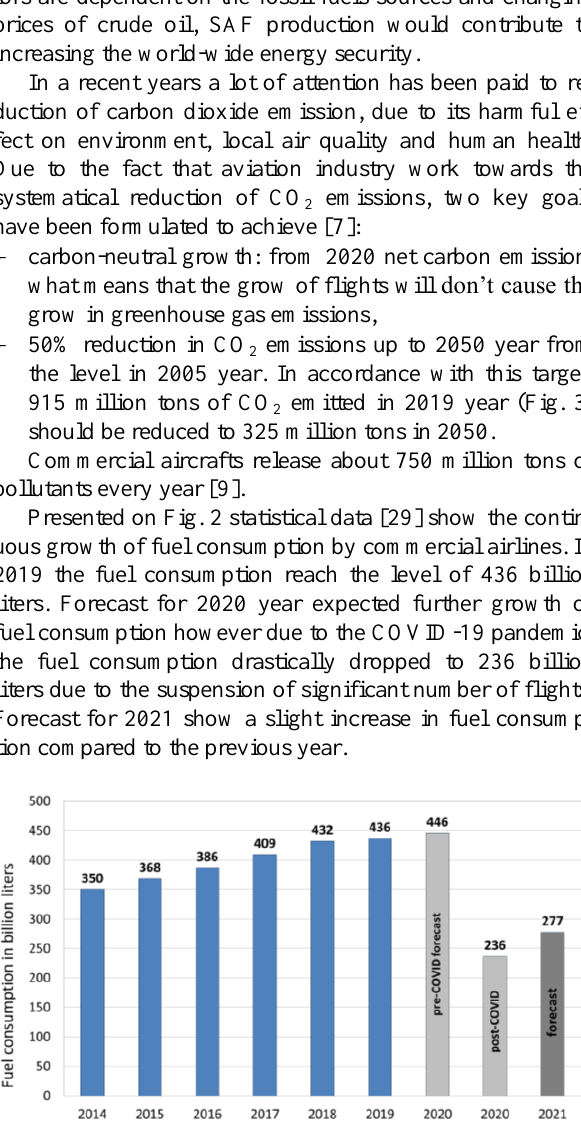
Fig. 2. Total fuel consumption of global commercial airlines [29, 57] An increase in fuel consumption is accompanied by an increase in CO emission, which is presented on Fig. 2. For 2 2019 the CO emission reach the value of 915 million 2 tones. The prediction made for 2020 year indicate the grow of emission up to 936 million tones, however the suspen- sion of flights significantly reduce this value to 495 million tones.